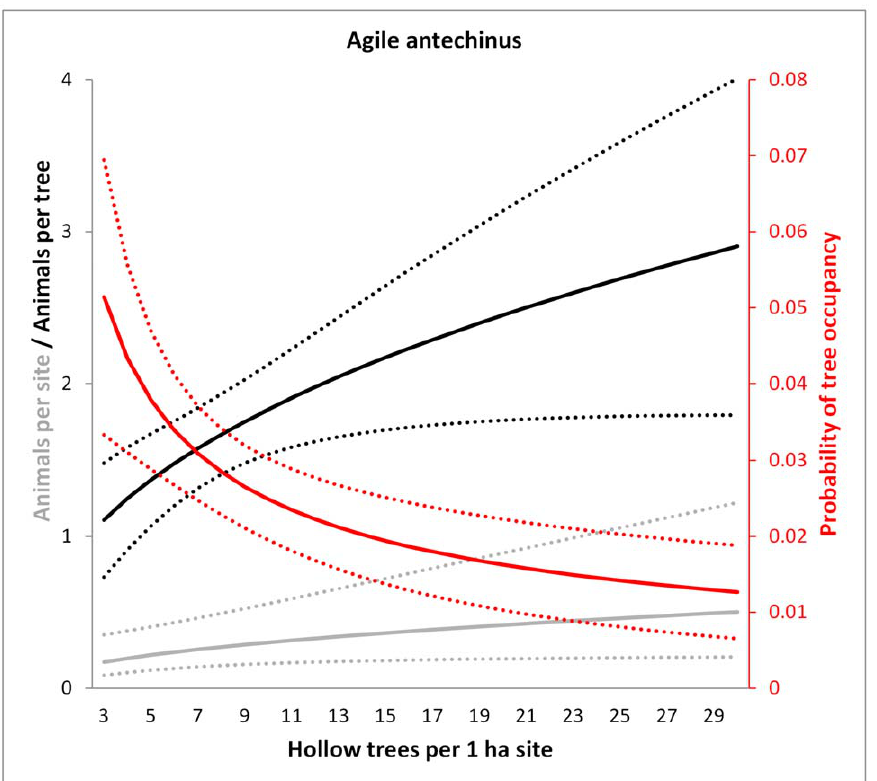
Figure 5. Model predictions for the agile antechinus of the number of animals per site (grey), the probability of occupancy per tree (red) and the number of animals per occupied tree (black) in relation to the number of hollow trees per 1 ha site. Dotted lines show 95% confidence intervals. Predictions were averaged over the non-represented variables (e.g. tree form).